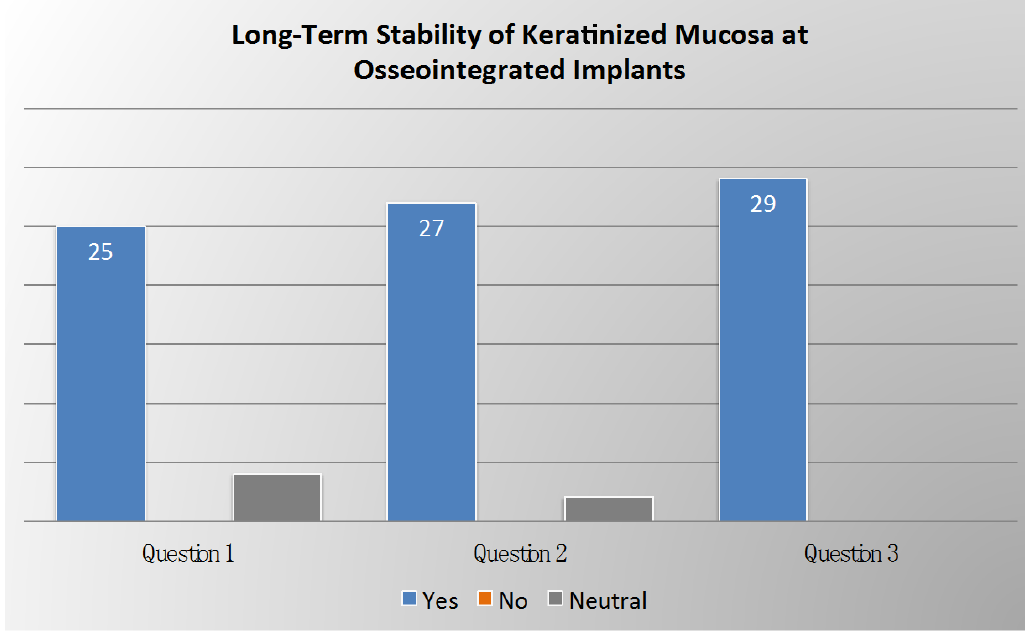
Figure 3. Voting results from the panel of experts regarding the long-term stability of keratinized mucosa at osseointegrated implants.